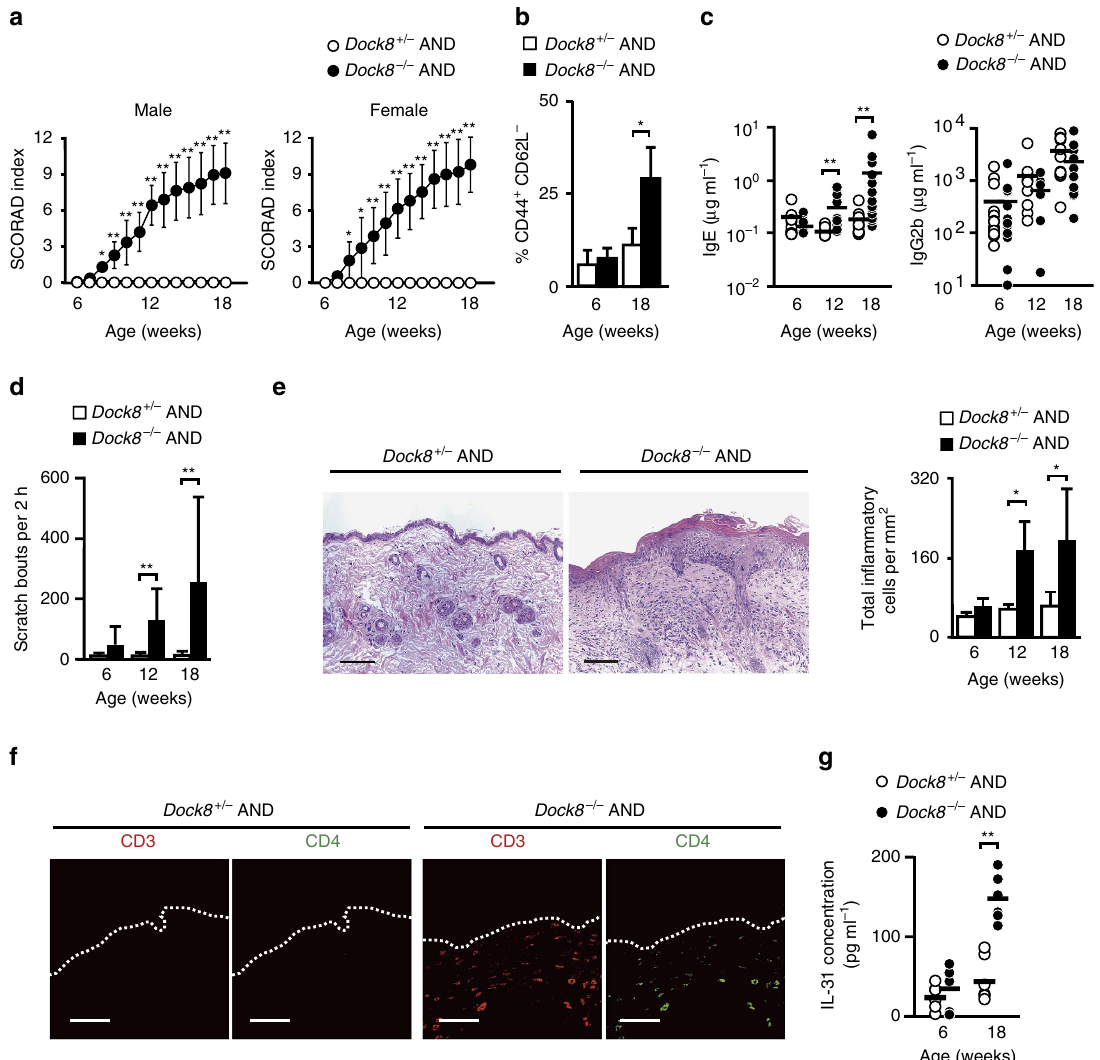
Figure 2 | Development of atopic skin inflammation in Dock8 (cid:2) / (cid:2) AND Tg mice. ( a ) SCORAD index of Dock8 þ / (cid:2) (male, n ¼ 20; female, n ¼ 15) and Dock8 (cid:2) / (cid:2) (male, n ¼ 20; female, n ¼ 15) AND Tg littermates. Data are expressed as mean ± s.d. * P o 0.05; ** P o 0.01 (two-tailed Student’s t -test). ( b ) The percentage of CD44 þ CD62L (cid:2) activated CD4 þ Tcells in total PLN CD4 þ Tcells from Dock8 þ / (cid:2) and Dock8 (cid:2) / (cid:2) ANDTg littermates at 6 and 18 weeks old. Data are expressed as mean ± s.d. of 4 mice per group. * P o 0.05 (two-tailed Mann–Whitney test). ( c ) Serum concentrations of IgE and IgG2b in Dock8 þ / (cid:2) and Dock8 (cid:2) / (cid:2) AND Tg mice at 6 ( n ¼ 13), 12 ( n ¼ 8 or 9) and 18 ( n ¼ 14) weeks old. The lines indicate the mean values. ** P o 0.01 (two-tailed Mann–Whitney test). ( d ) Comparison of scratching bouts between Dock8 þ / (cid:2) and Dock8 (cid:2) / (cid:2) AND Tg mice at 6 ( n ¼ 8), 12 ( n ¼ 6) and 18 ( n ¼ 8) weeks old. Data are expressed as mean ± s.d. ** P o 0.01 (two-tailed Mann–Whitney test). ( e ) Haematoxylin and eosin staining of the skin from 18-week-old littermates. Scale bars, 100 m m. The number of inflammatory cells per mm 2 was compared between Dock8 þ / (cid:2) and Dock8 (cid:2) / (cid:2) AND Tg mice. In each experiment, three fields were examined per mouse. Data are expressed as mean ± s.d. of four mice group. * P o 0.05 (two-tailed Mann–Whitney test). ( f ) Immunofluorescence staining showing infiltration of CD4 þ Tcells in the skin of Dock8 (cid:2) / (cid:2) AND Tg mice. Scale bars, 50 m m. ( g ) Serum concentrations of IL-31 in Dock8 þ / (cid:2) and Dock8 (cid:2) / (cid:2) AND Tg mice at 6 ( n ¼ 6) and 18 ( n ¼ 6) weeks old. The lines indicate the mean values. ** P o 0.01 (two-tailed Student’s t